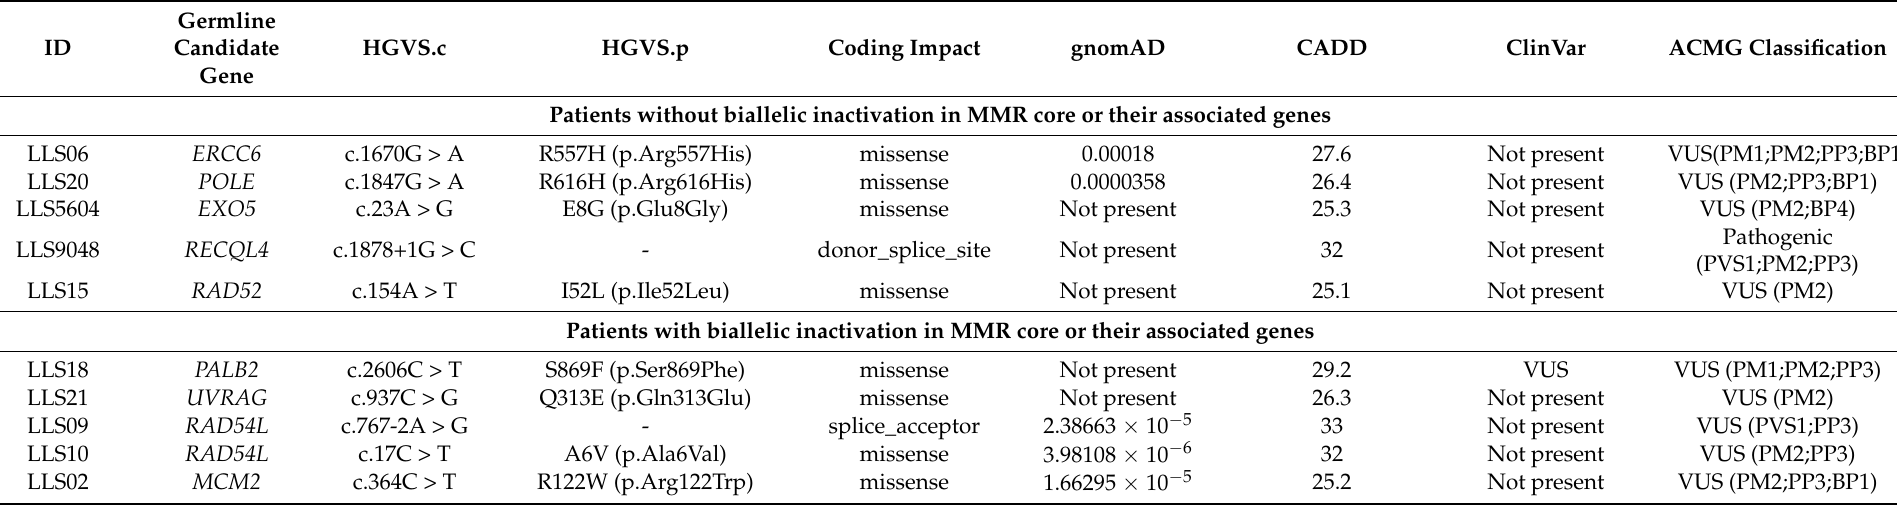
Table 3. Germline candidate variants. Results of the whole exome sequencing analysis with candidate variants with DNA repair